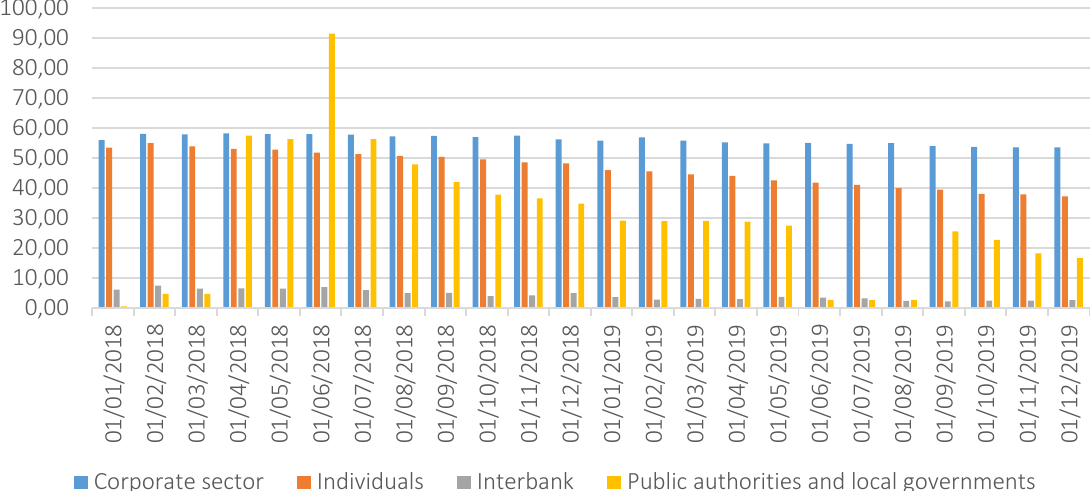
Figure 9. Dynamics of NPLs by sectors of the Ukrainian